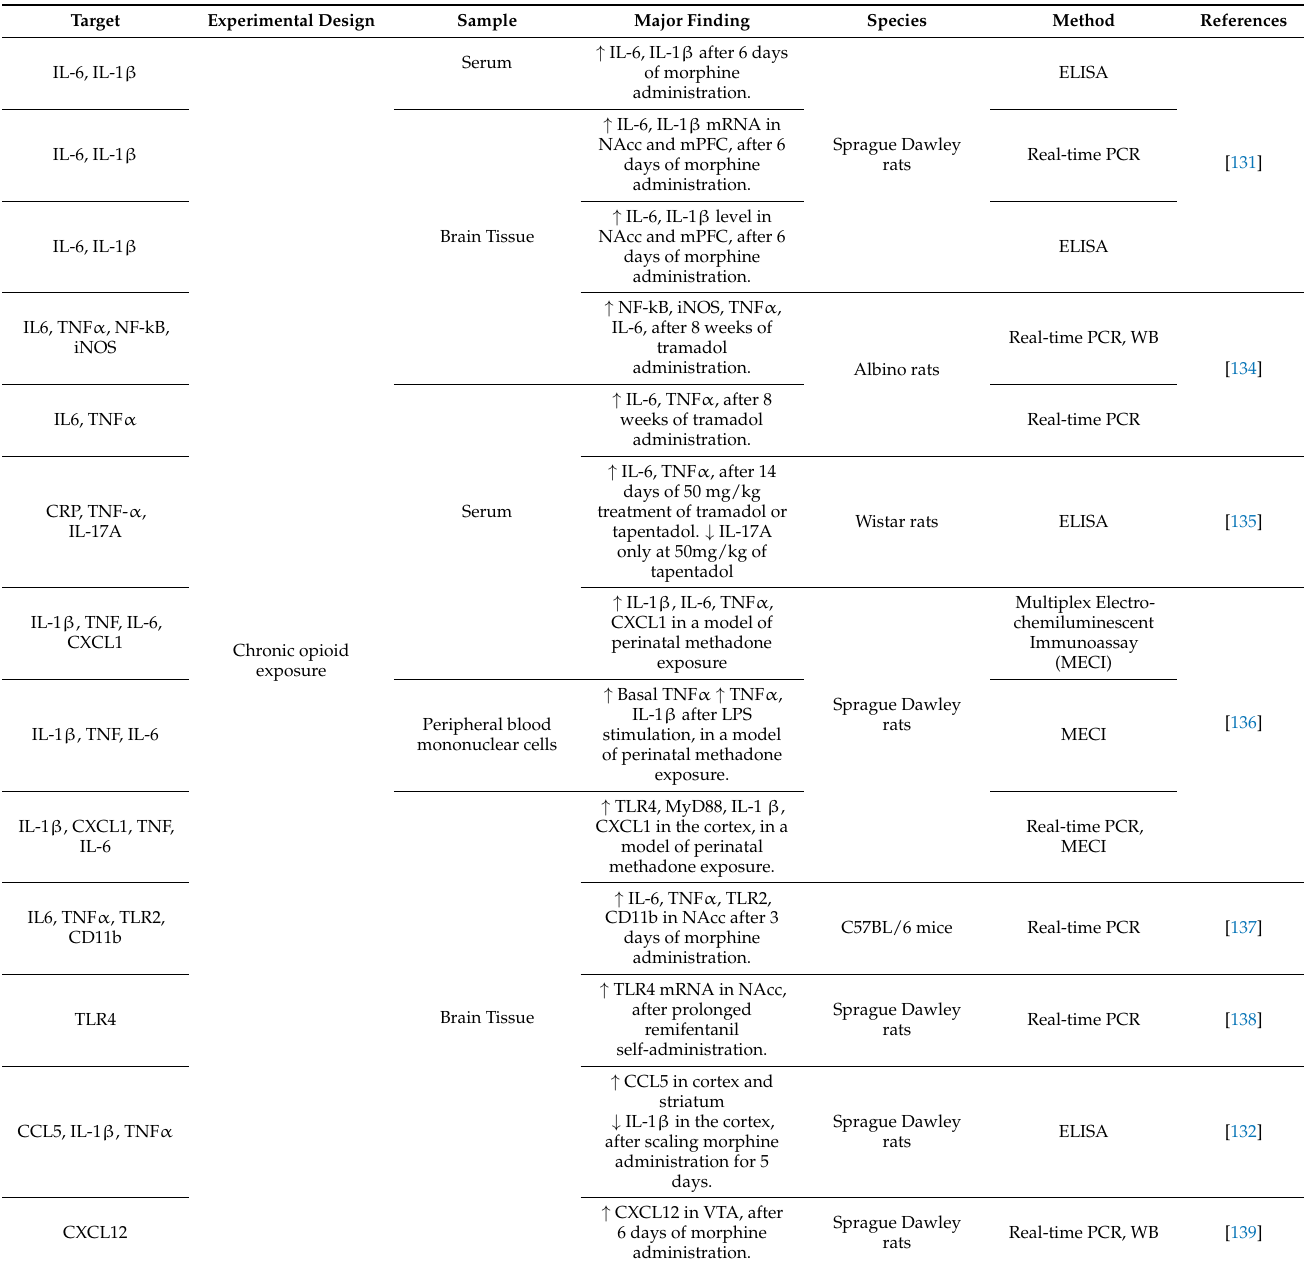
Table 7. Opioid Use Disorder: Chronic Opioid